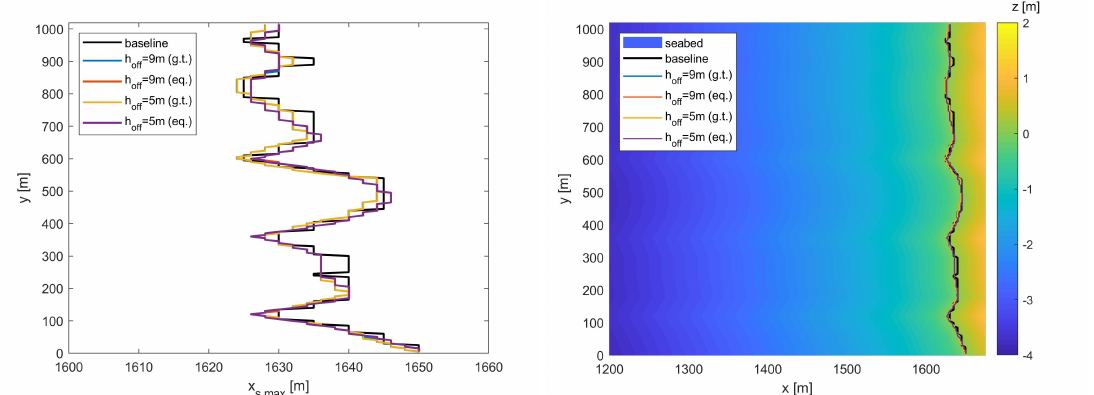
Figure 13. Comparison of max inundation due to the ESE forcing: results of baseline (black line) and flood (colored lines) simulations ( left panel ). The overlap with the original bathymetry is also shown ( right panel